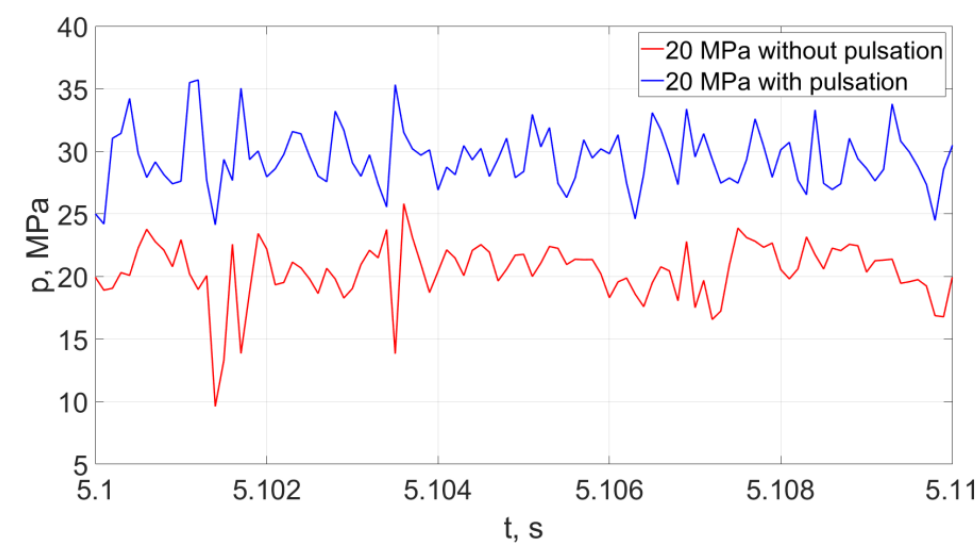
Figure 22. Distributions of hydrodynamic impulses occurring in the water stream (with a pressure of 20 MPa at a distance of 50 mm from the outlet from the pulsating head), produced in the head for drilling holes in the water environment and in the “continuous” stream operating under similar conditions.